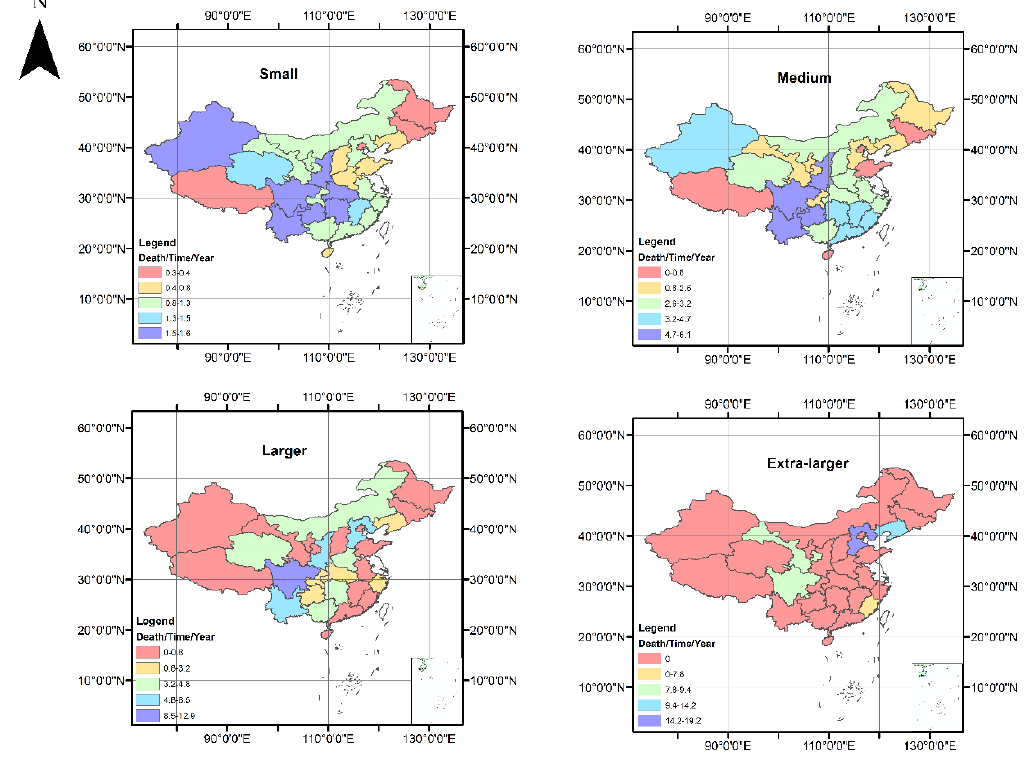
Figure 8. Intensity distributions of flash flood in different levels in 2016. Death/Time/Year: the average number of deaths each year due to flash floods.